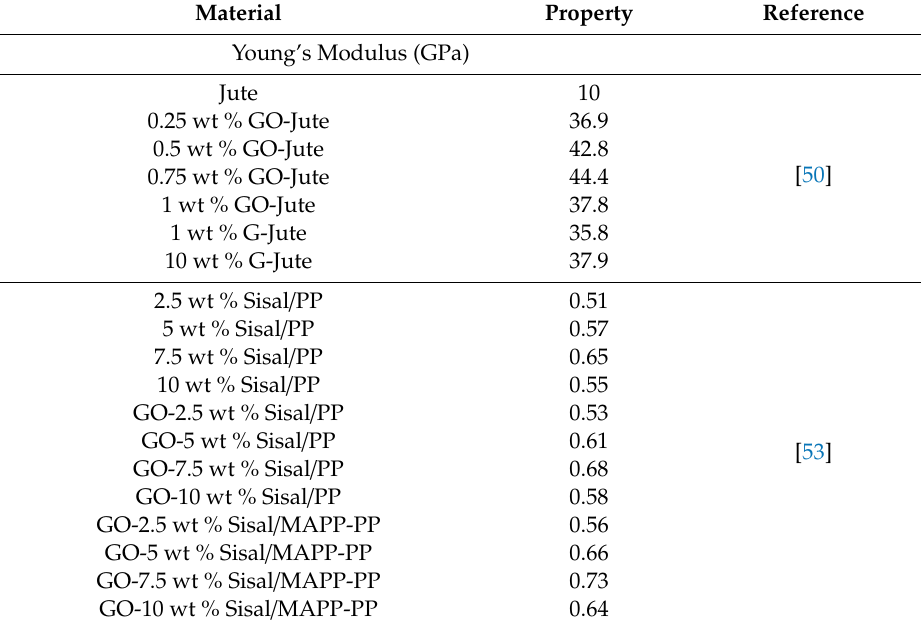
Table 3. Cont. Material Property